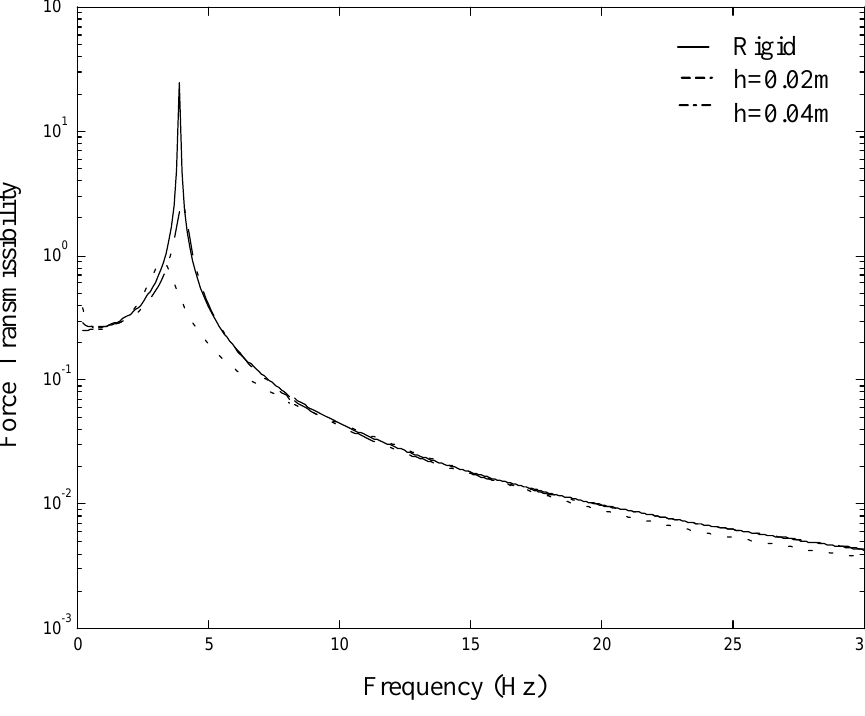
Fig. 6. Vertical force transmission at mount 1-infinite plate with heavy fluid loading under the unit vertical force excitation ( F x ) at c.g. of rigid